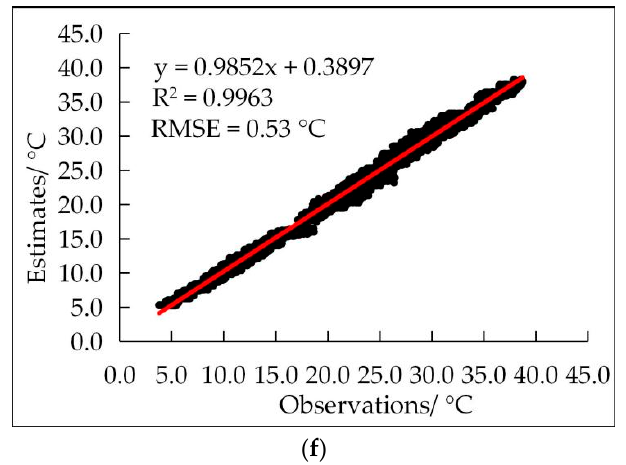
Figure A4. The linear fitting results of the observed and simulated values are reduced by 8 temper- ature sensors. ( a ) Reduced B and C columns; ( b ) Reduced B and D columns; ( c ) Reduced B and E columns; ( d ) Reduced C and D columns; ( e ) Reduced C and E columns; ( f ) Reduced D and E columns.